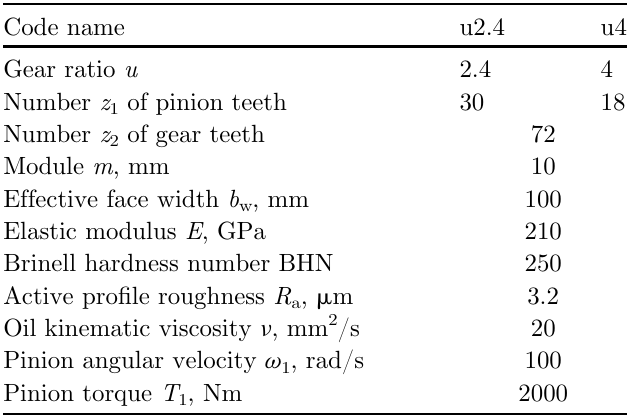
Table 3. Parameters of the simulated gear pairs and operating